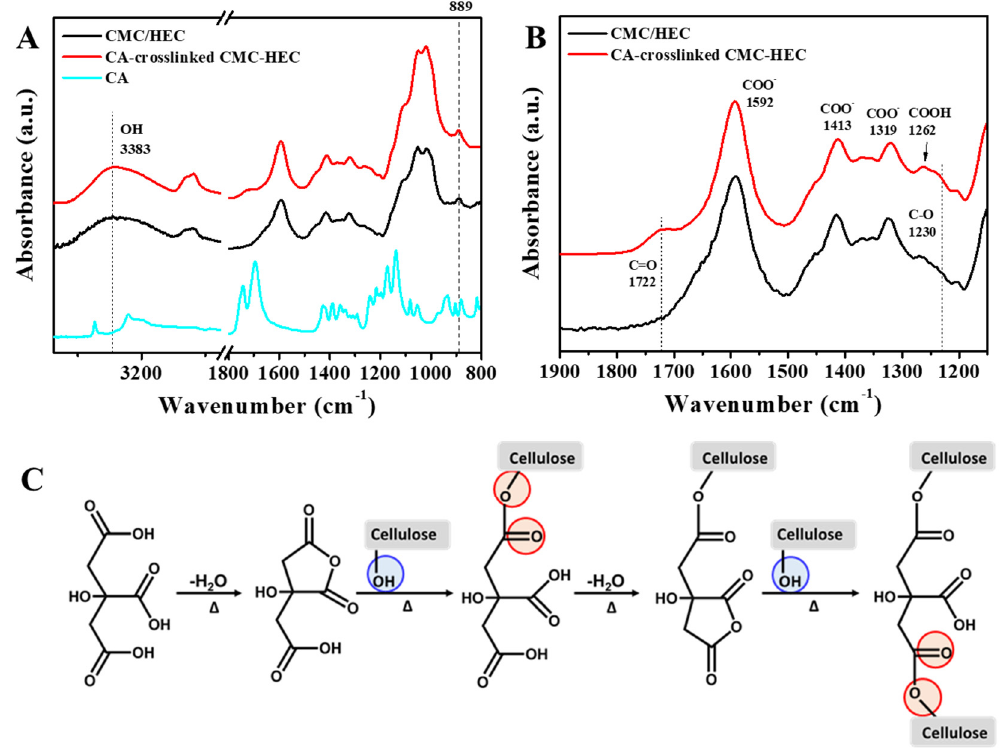
Figure 2. FTIR spectra of CMC/HEC, CA-crosslinked CMC–HEC, and CA in the ranges of ( A ) 3750–800 cm − 1 and ( B ) 1900–1150 cm − 1 . ( C ) Scheme of the crosslinking mechanism of cellulose with CA. Table 1. Intensity ratio of the characteristic band associated with the crosslinking reaction of CMC– HEC via citric acid.